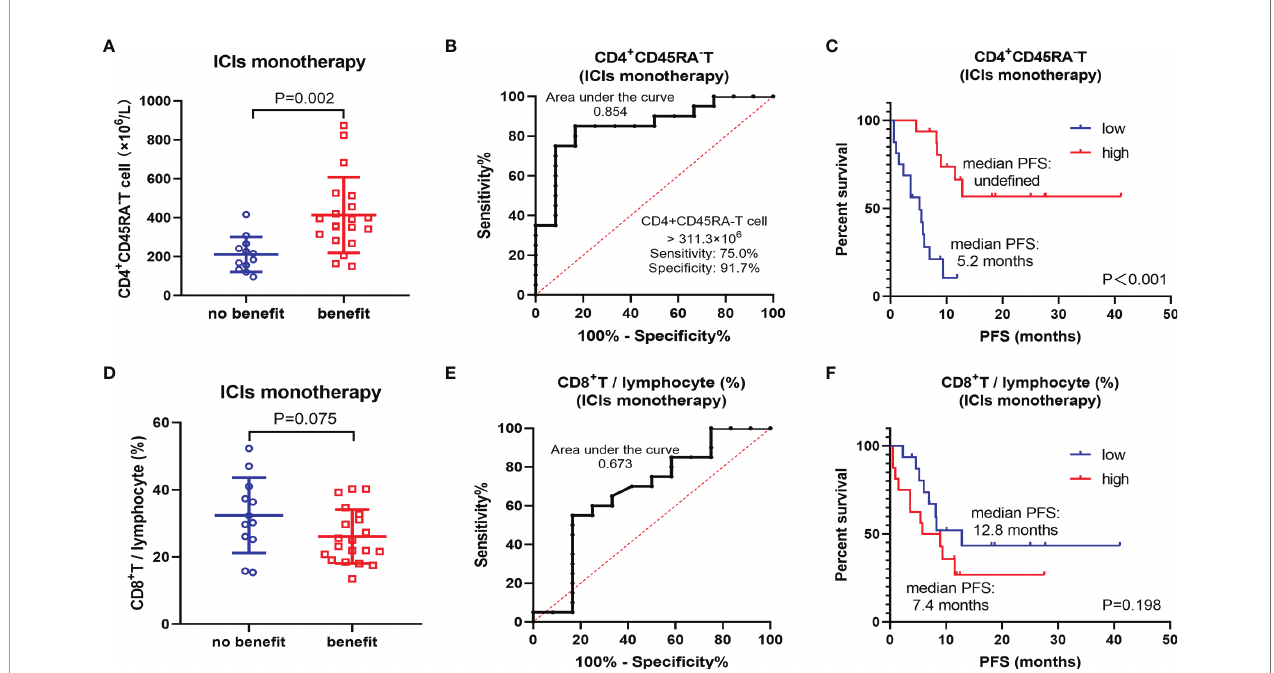
FIGURE 2 | Subgroup analysis of ICIs monotherapy. (A) Differences of CD4 + CD45RA − T cell between bene fi t group and non-bene fi t group. (B) ROC curve of CD4 + CD45RA − T cell. (C) Kaplan – Meier survival curve of different levels of CD4 + CD45RA − T cell. (D) Differences of CD8 + T/lymphocyte (%) between bene fi t group and non-bene fi t group. (E) ROC curve of CD8 + T/lymphocyte (%). (F) Kaplan – Meier survival curve of different levels of CD8 + T/lymphocyte (%).